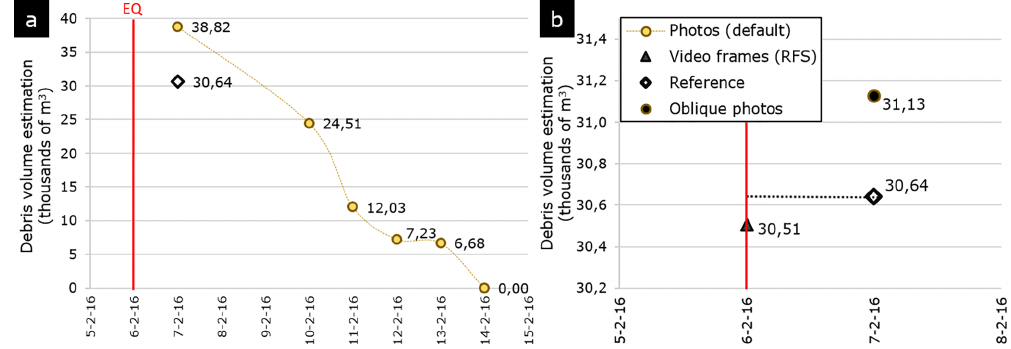
Figure 11. (a) Debris volume change analysis using the Tainan multi-temporal photo-based 3DPC and reference model. (b) Volume es- timations for video-based 3DPC (random frame selection), oblique-photo-based 3DPC, and reference model. Red line: earthquake (EQ) date.